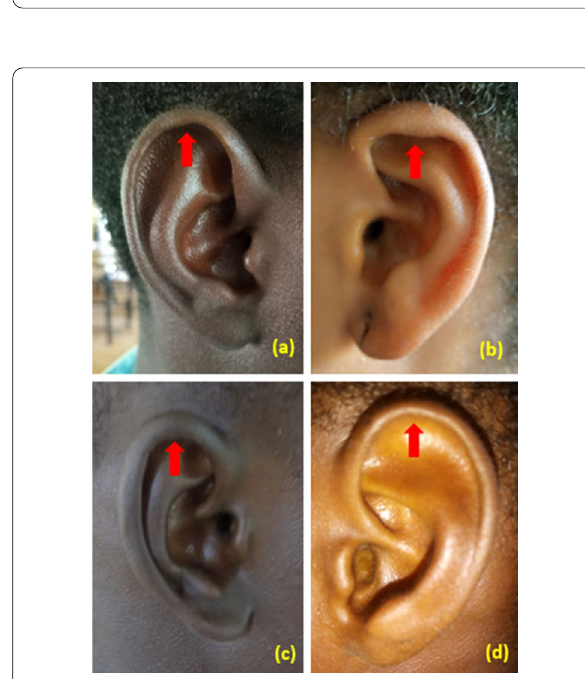
Fig. 7 Photographs of forms of ear helix: concave marginal ( a ), wide